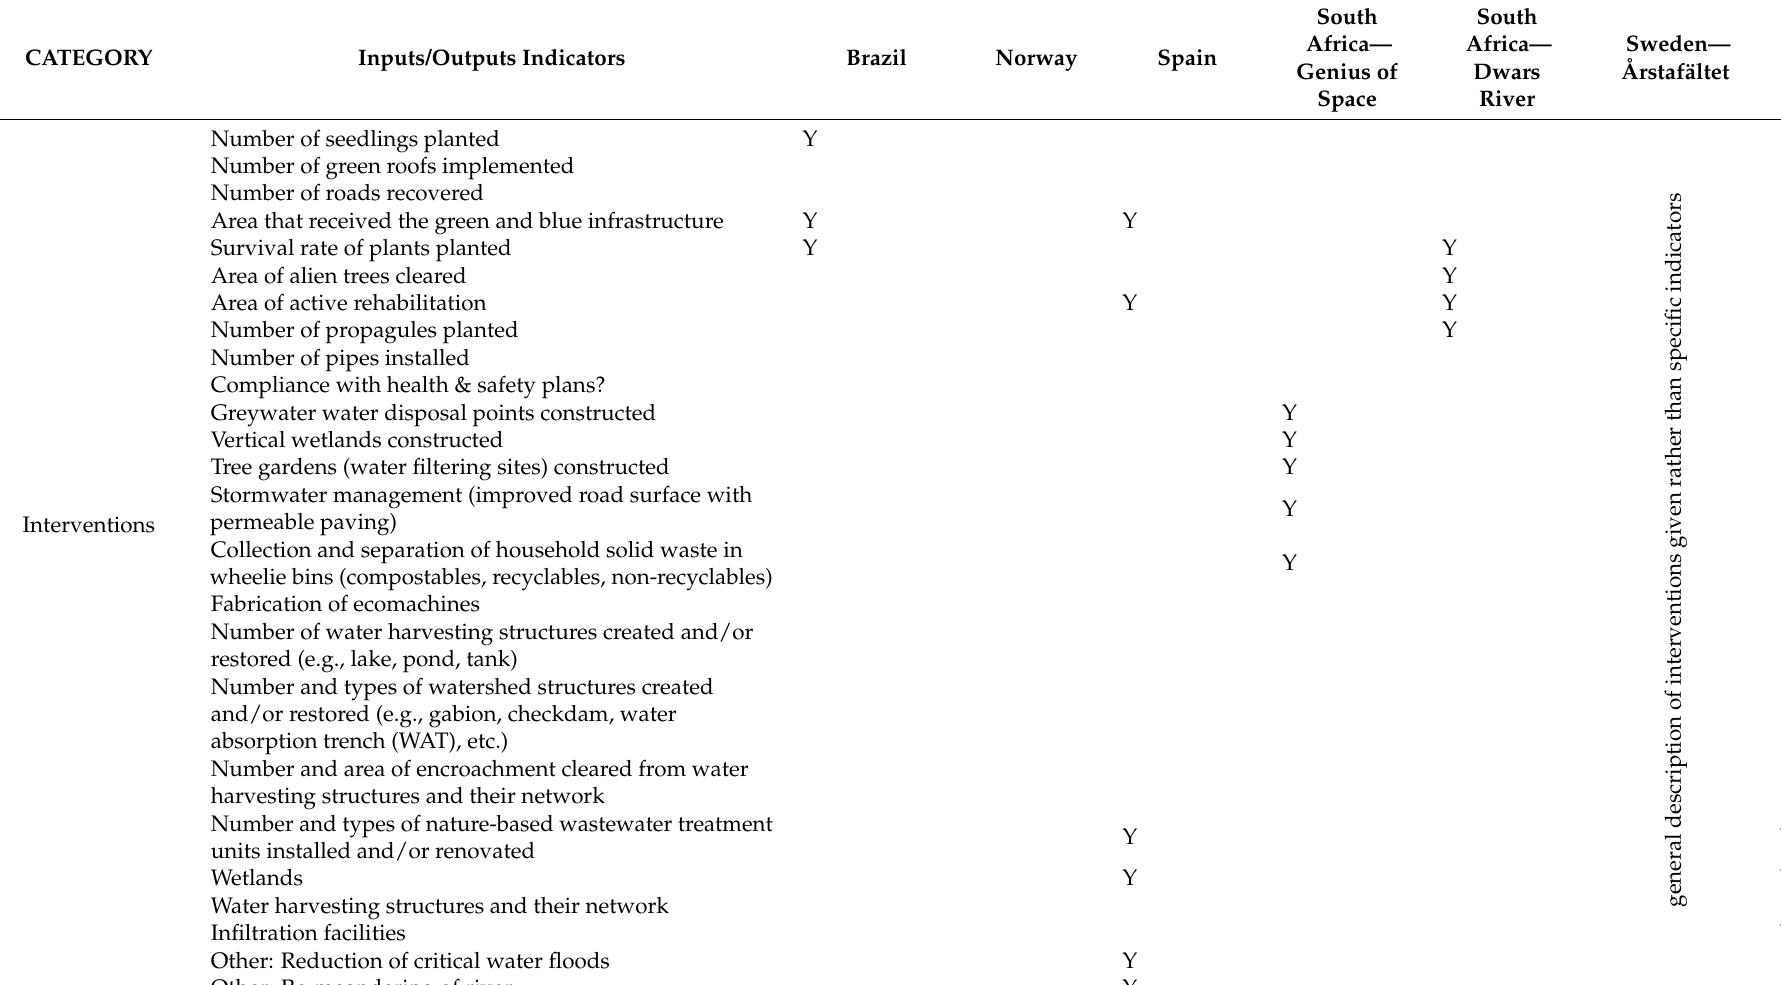
Table 4. Process-based environmental indicators according to whether each case study considered the indicator as relevant to be assessed (indicated with ‘Y’ for yes).